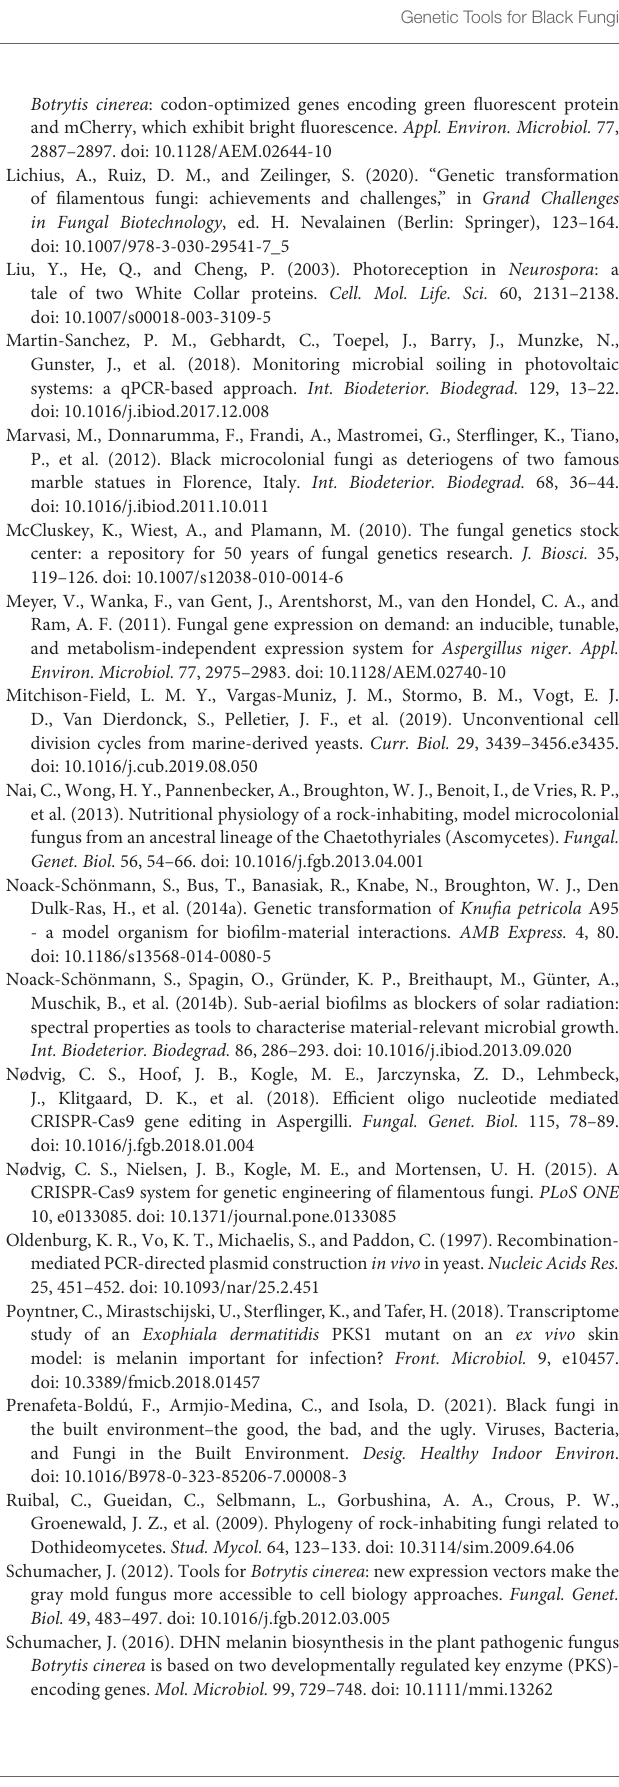
Frontiers in Fungal Biology |